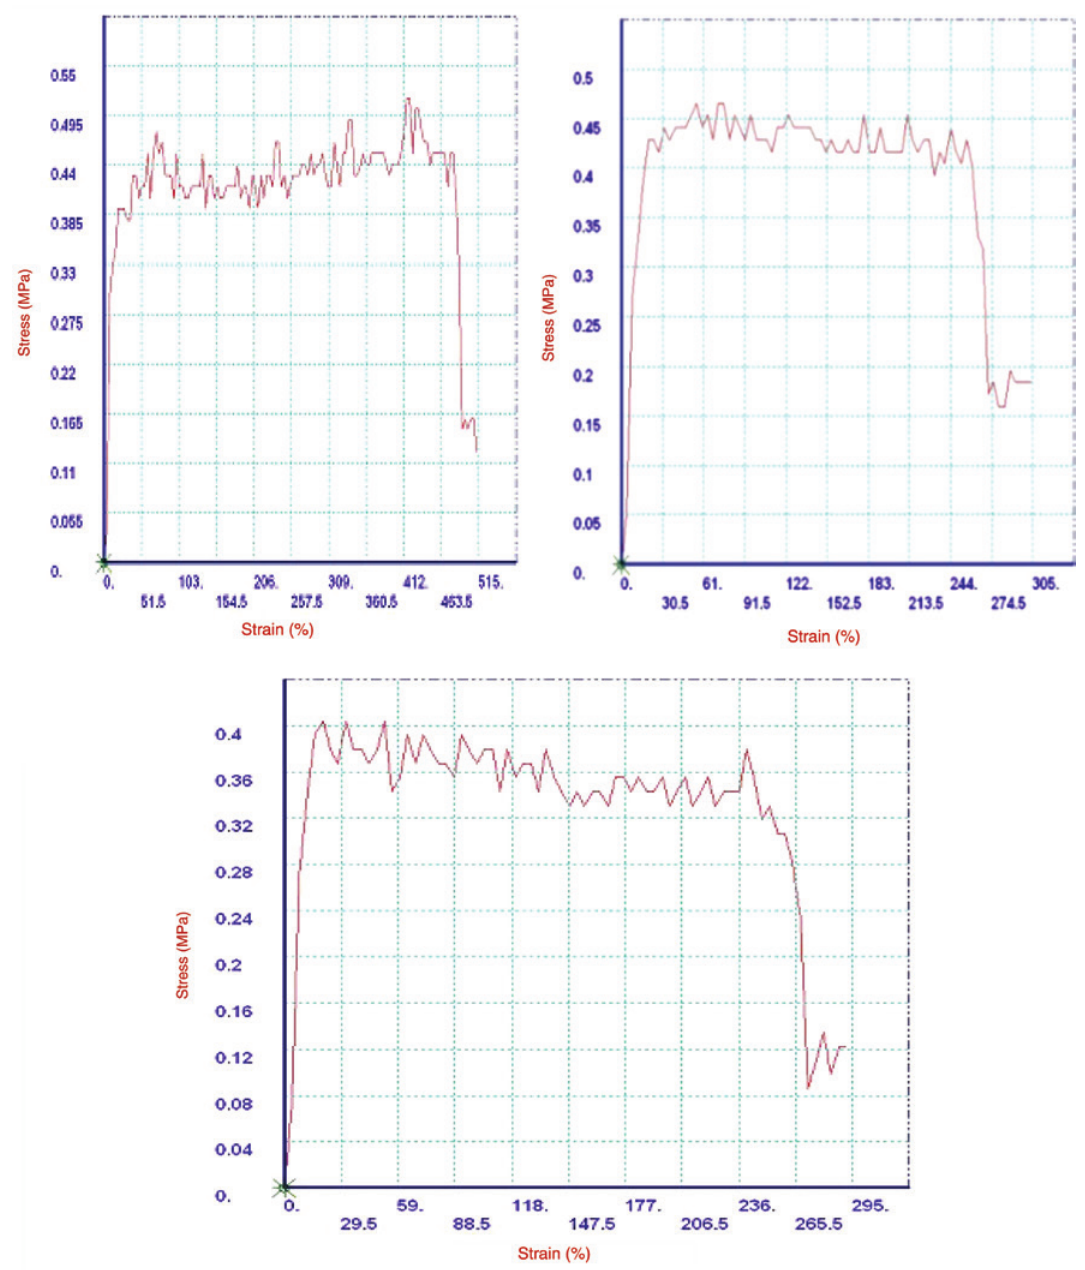
Figure 6: Stress-strain curve of vulcanized NR after cold resistance at − 60 ° C for 8 h.